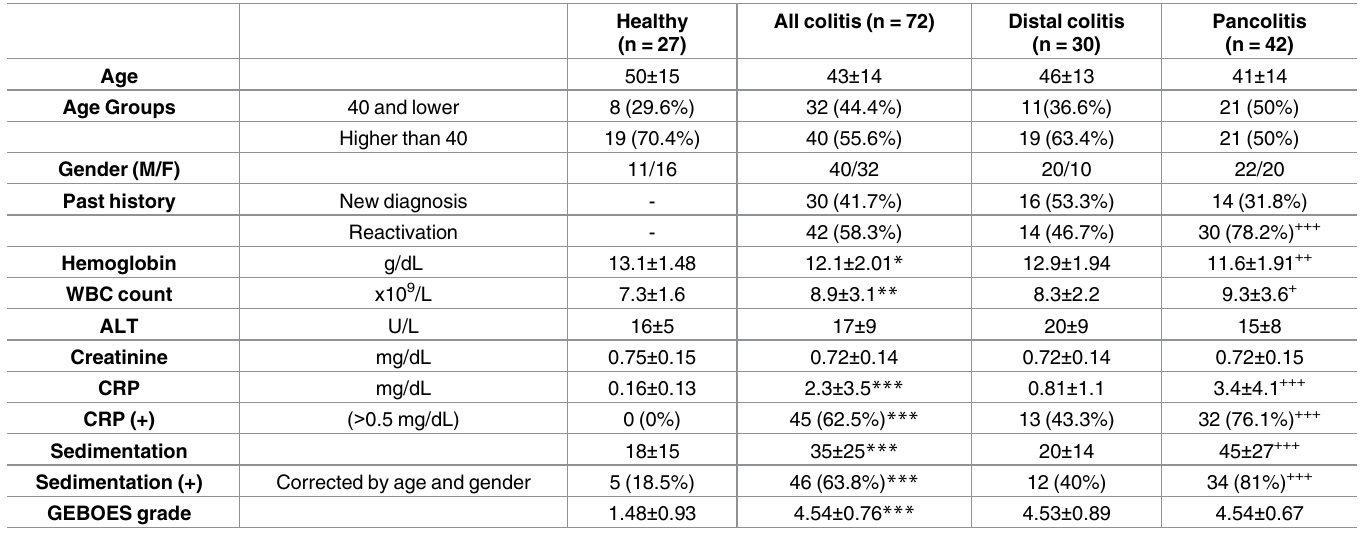
Table 1. Distribution of clinical and laboratory parameters of patients with ulcerative colitis and healthy controls.